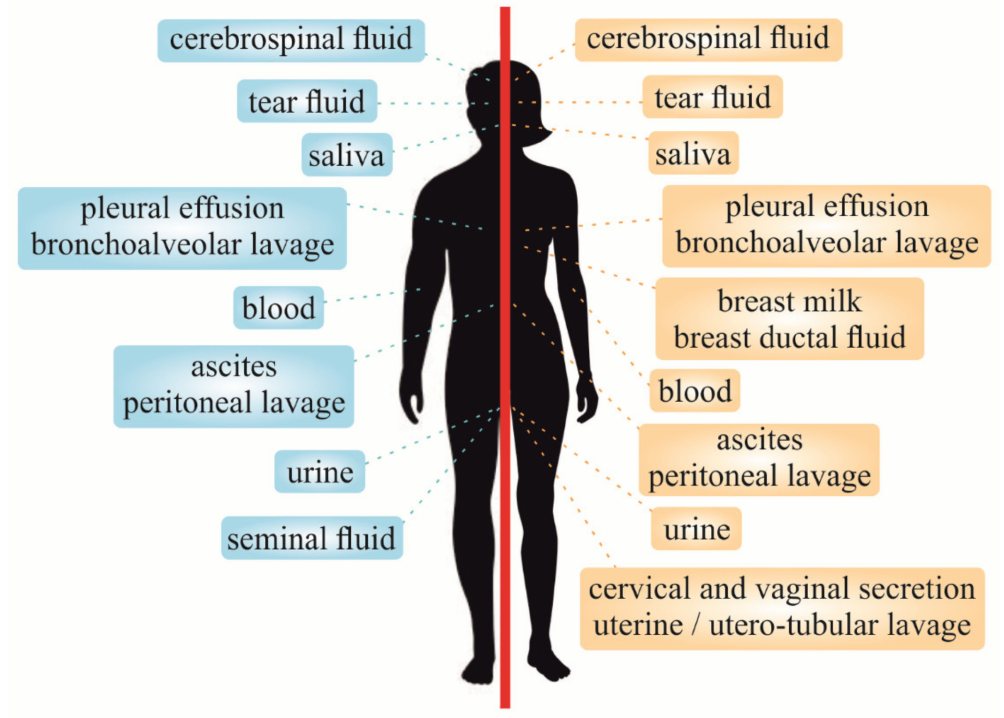
Figure 1. Analyses of the most prominent liquid biopsy types utilized for cancer-relevant biomarkers in males (left) and females